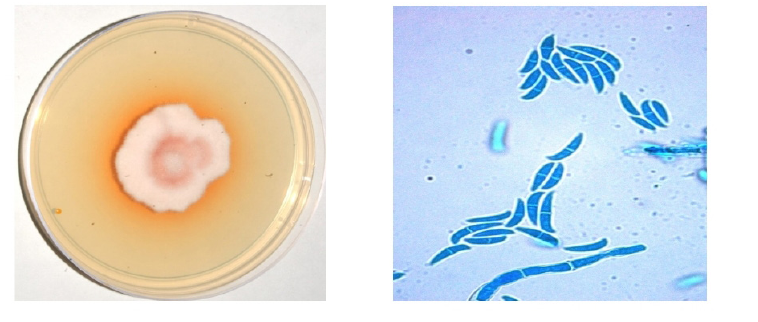
Fig. 1. Phenotypic and Microscopic identification of Curvularia species by Lacto-Phenol Cotton